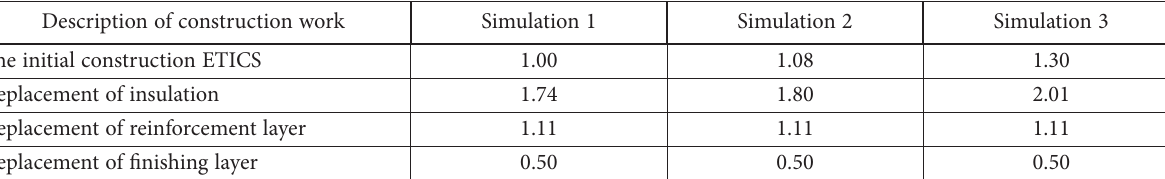
Table 4. The comparative ratio of the construction and repair costs to the initial construction cost of simulation